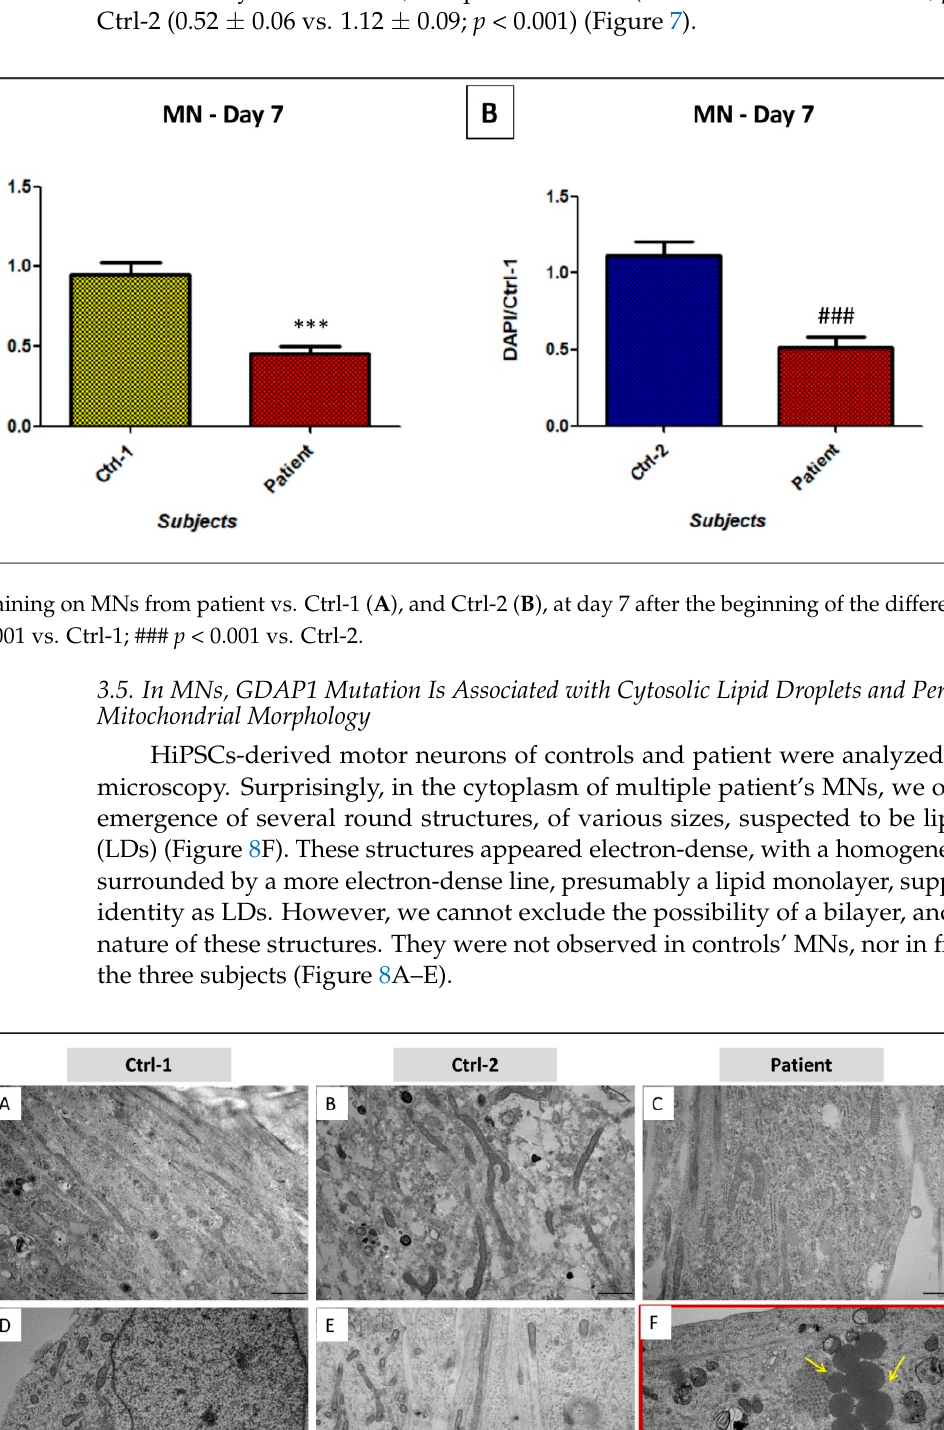
Figure 8. Ultrastructure analysis, by EM, on fibroblasts of Ctrl-1 ( A ), Ctrl-2 ( B ), and patient ( C ), and MNs of Ctrl-1 ( D ), Ctrl-2 ( E ), and patient ( F ). Lipid droplets (LDs), in patient’s MNs, are indicated by yellow arrows. Scale bar = 1 µ m in ( A – D ); Scale bar = 500 nm in ( E , F ).